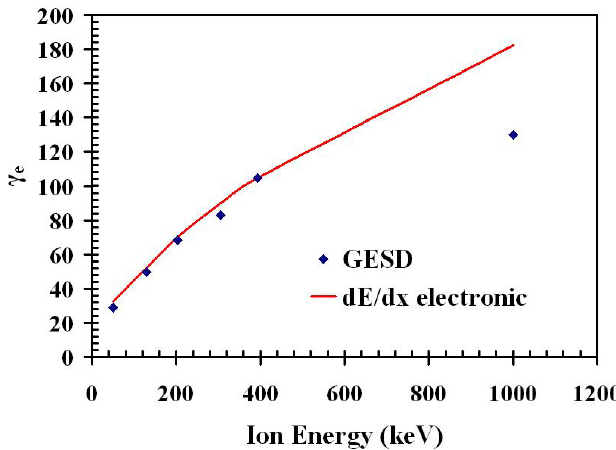
FIG. 5. (Color) Electron yield obtained with Gas-Electron Source Diagnostic at 88 degrees compared with the electronic stopping power normalized to the experimental electron yield at 393